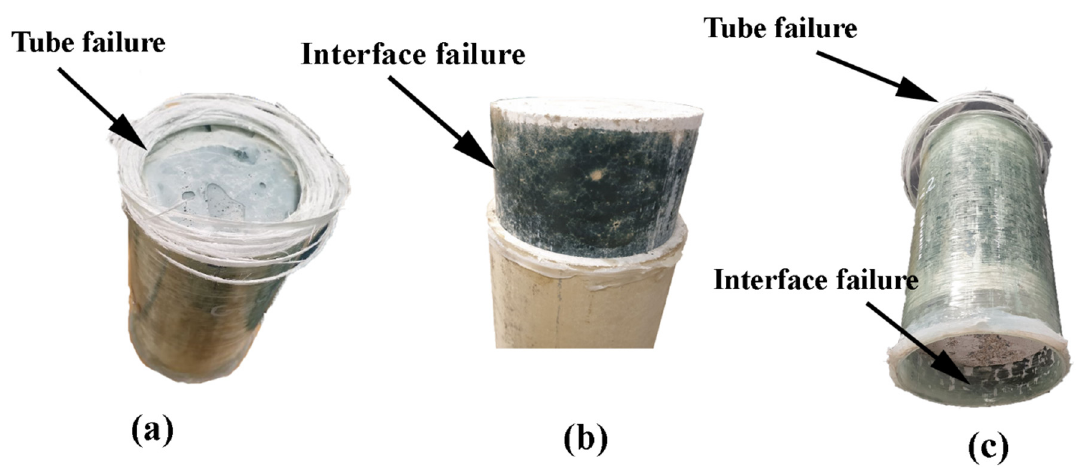
Figure 4. Possible failure modes in the pushout test of concrete filled FRP tubes: ( a ) tube failure before slip initiation; ( b ) slip between the concrete and tube, both interface failure and surface crushing; and ( c ) tube failure combined with some slip [11].